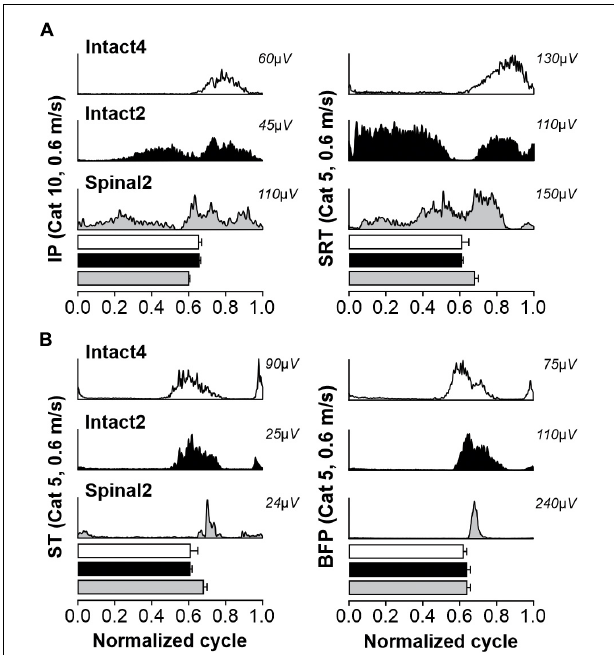
FIGURE 8 | Second bursts of activity in muscles with a flexor action at the hip and knee joints during quadrupedal or hindlimb-only locomotion in intact and spinal cats. The figure shows averaged rectified muscle activity normalized to the cycle for selected muscles during Intact4, Intact2 and Spinal2 conditions at 0.6 m/s for Cats 5 and 10: in (A) IP and SRT and (B) ST and BFP muscles. Horizontal bars represent averaged stance durations normalized to the cycle. For each muscle, 10–15 cycles were averaged. IP, iliopsoas; SRT, anterior sartorius; ST, semitendinosus; BFP, biceps femoris